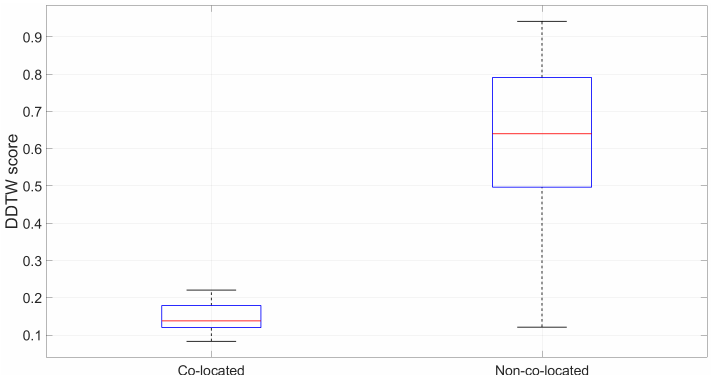
Figure 15. Comparison of the DDTW score between 1-stop co-located and non-co-located trips in the training